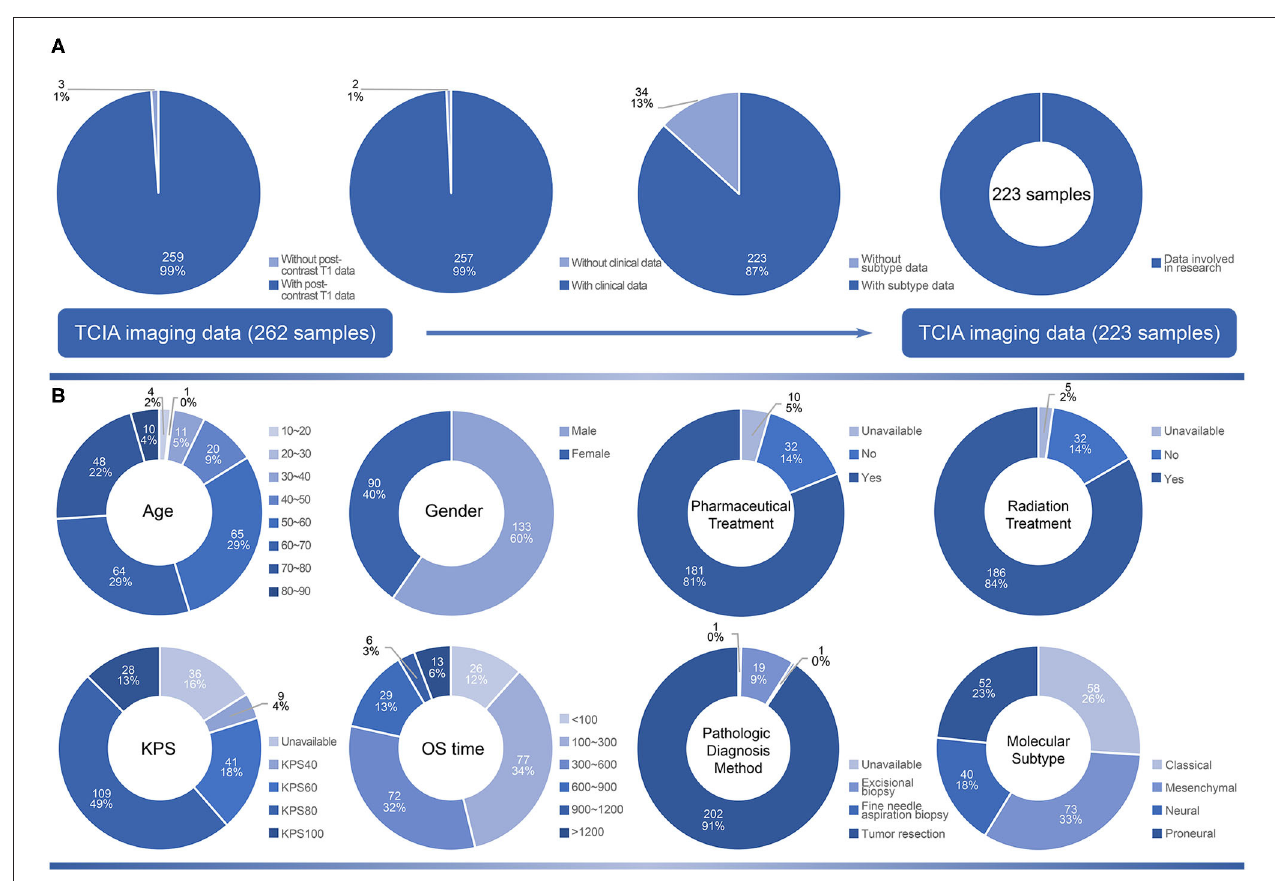
FIGURE 1 | The selection criteria of the study and demographic characteristics of samples. (A) The original 262 samples collected from TCIA. According to the availability of post-contrast T1 image, clinical data and subtype data, 223 samples were included in the study. (B) The distribution of clinical variables including age, gender, pharmaceutical treatment, radiation treatment, KPS, OS time, pathologic diagnosis method and molecular subtype in 223